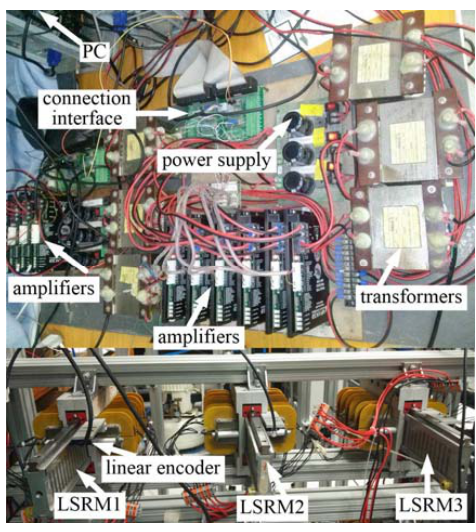
Figure 4. Experiment setup.